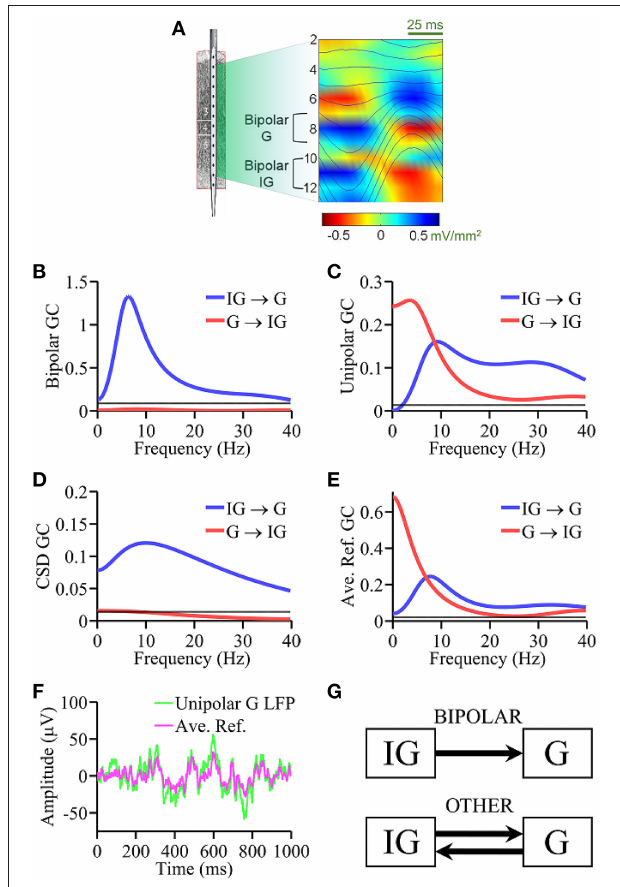
FIGURE 3 | Laminar recording from monkey V4. (A) Schematic of the multielectrode with 14 equally spaced (200 µ m) contacts and alpha generators as identified by phase realigned and averaged (PRAT) CSD (color-coded) and LFPs (smooth traces, blue). Granger causality spectral analysis using (B) bipolar data, (C) unipolar data, (D) CSD data, and (E) average re-referenced data. (F) Comparison of unipolar LFPs from granular layer and average reference signals. (G) Schematic summarizing the Granger causality results where “OTHER” includes unipolar data, average re-referenced data and CSD data. Bipolar results are in agreement with ground truth. Black horizontal lines in (B–E) represents the level of statistical significance ( p < 0.05